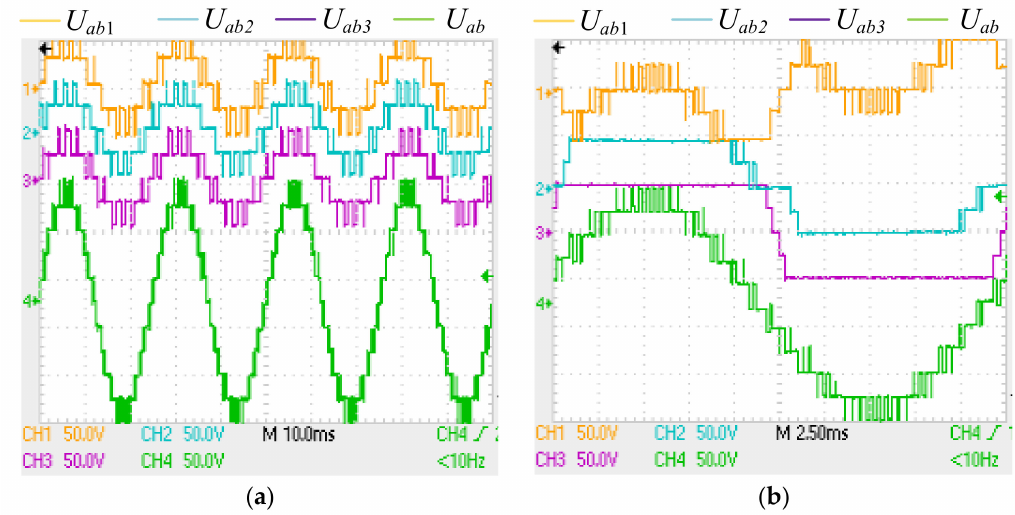
Figure 12. The static waveforms of three-module 3LNPC-CC. ( a ) The PSC modulation of 3LNPC-CC; ( b ) proposed strategy of 3LNPC-CC.